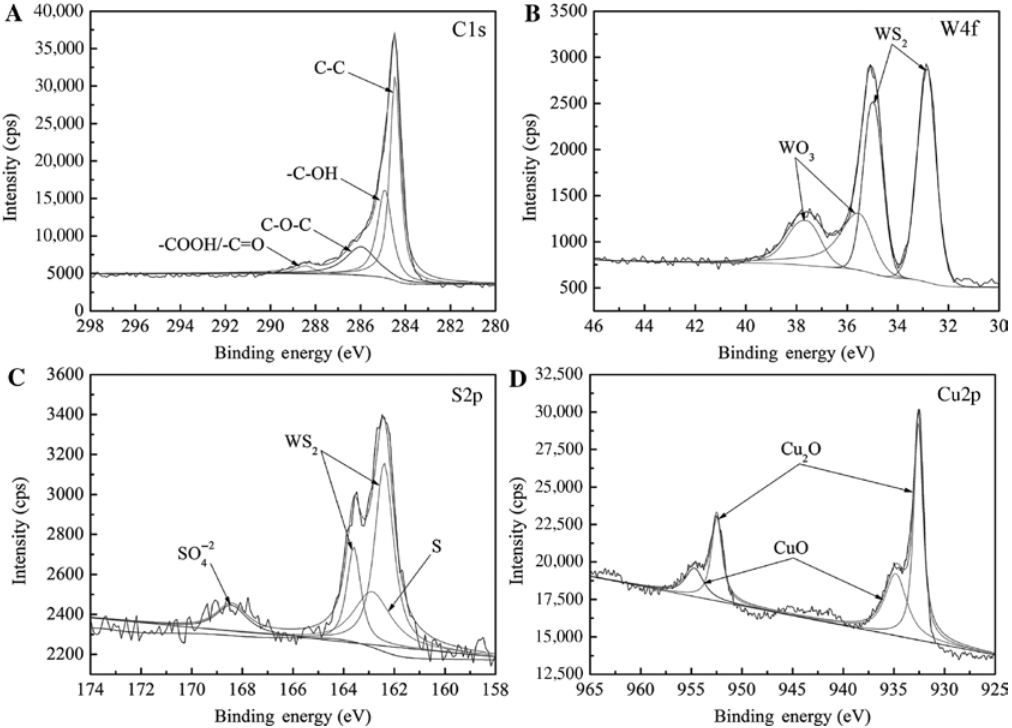
-graphite-multi-wall WS nanotubes (Cu-WS -G- 2 2 2